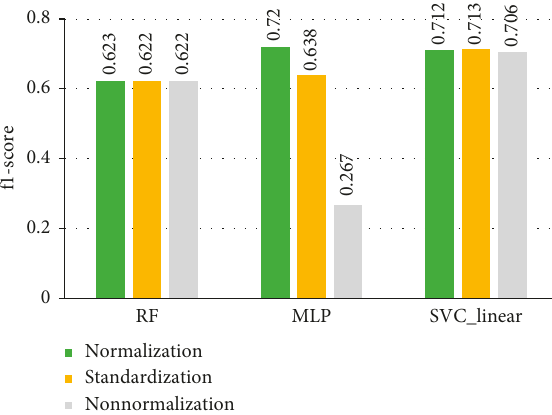
Figure 2: Comparison of with and without normalization.